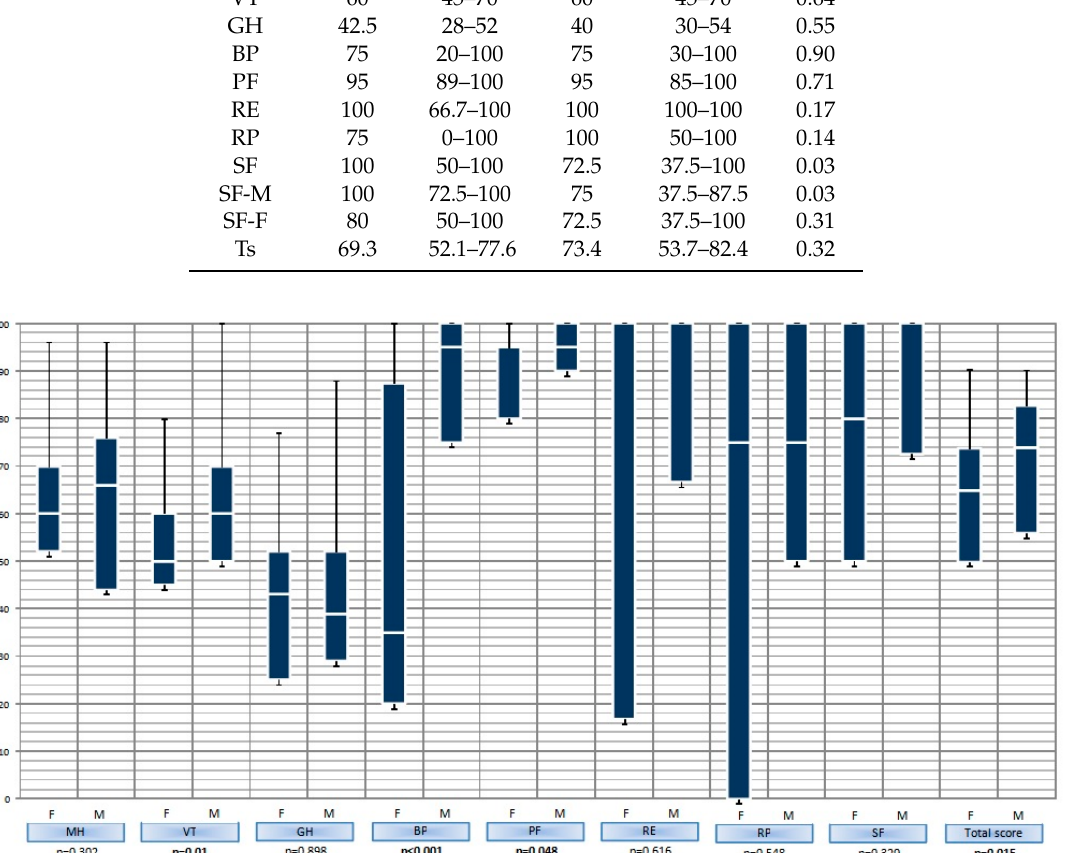
Figure 1. Differences in the quality of life (QoL) in type 1 diabetes mellitus (T1DM) in relation to SF-36 domains. F—female, M—man, mental health (MH), vitality (VT), general health (GH), bodily pain (BP), physical functioning (PF), role limitations due to emotional problems (RE), role limitations due to physical problems (RP), social functioning (SF).